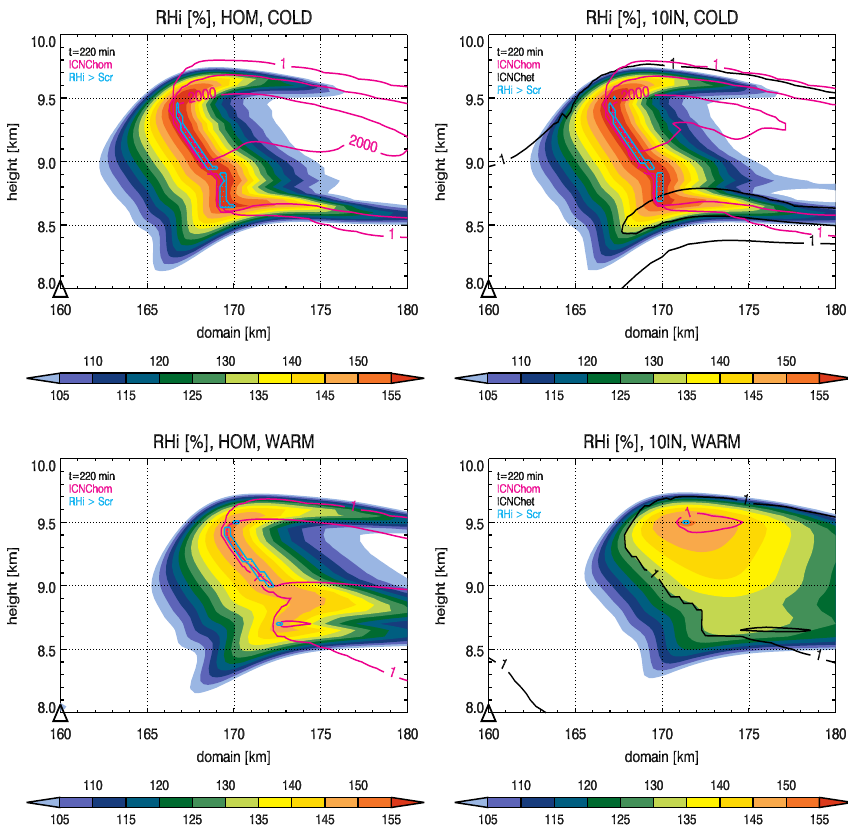
Figure 8. Relative humidity with respect to ice (RHi) for the simulations HOM (left column) and 10 IN (right column), for the cold (upper row) and warm (lower row) temperature profiles for t = 220min. Colours denote RHi in percent; black lines the heterogeneously frozen ice crystals with lines for 1 and 10L − 1 ; pink lines the homogeneously frozen crystals with lines for 1, 100 and 2000L − 1 ; and the blue dashed area shows where RHi exceeds the critical supersaturation for homogeneous freezing S cr = 2 . 583 − T Lohmann